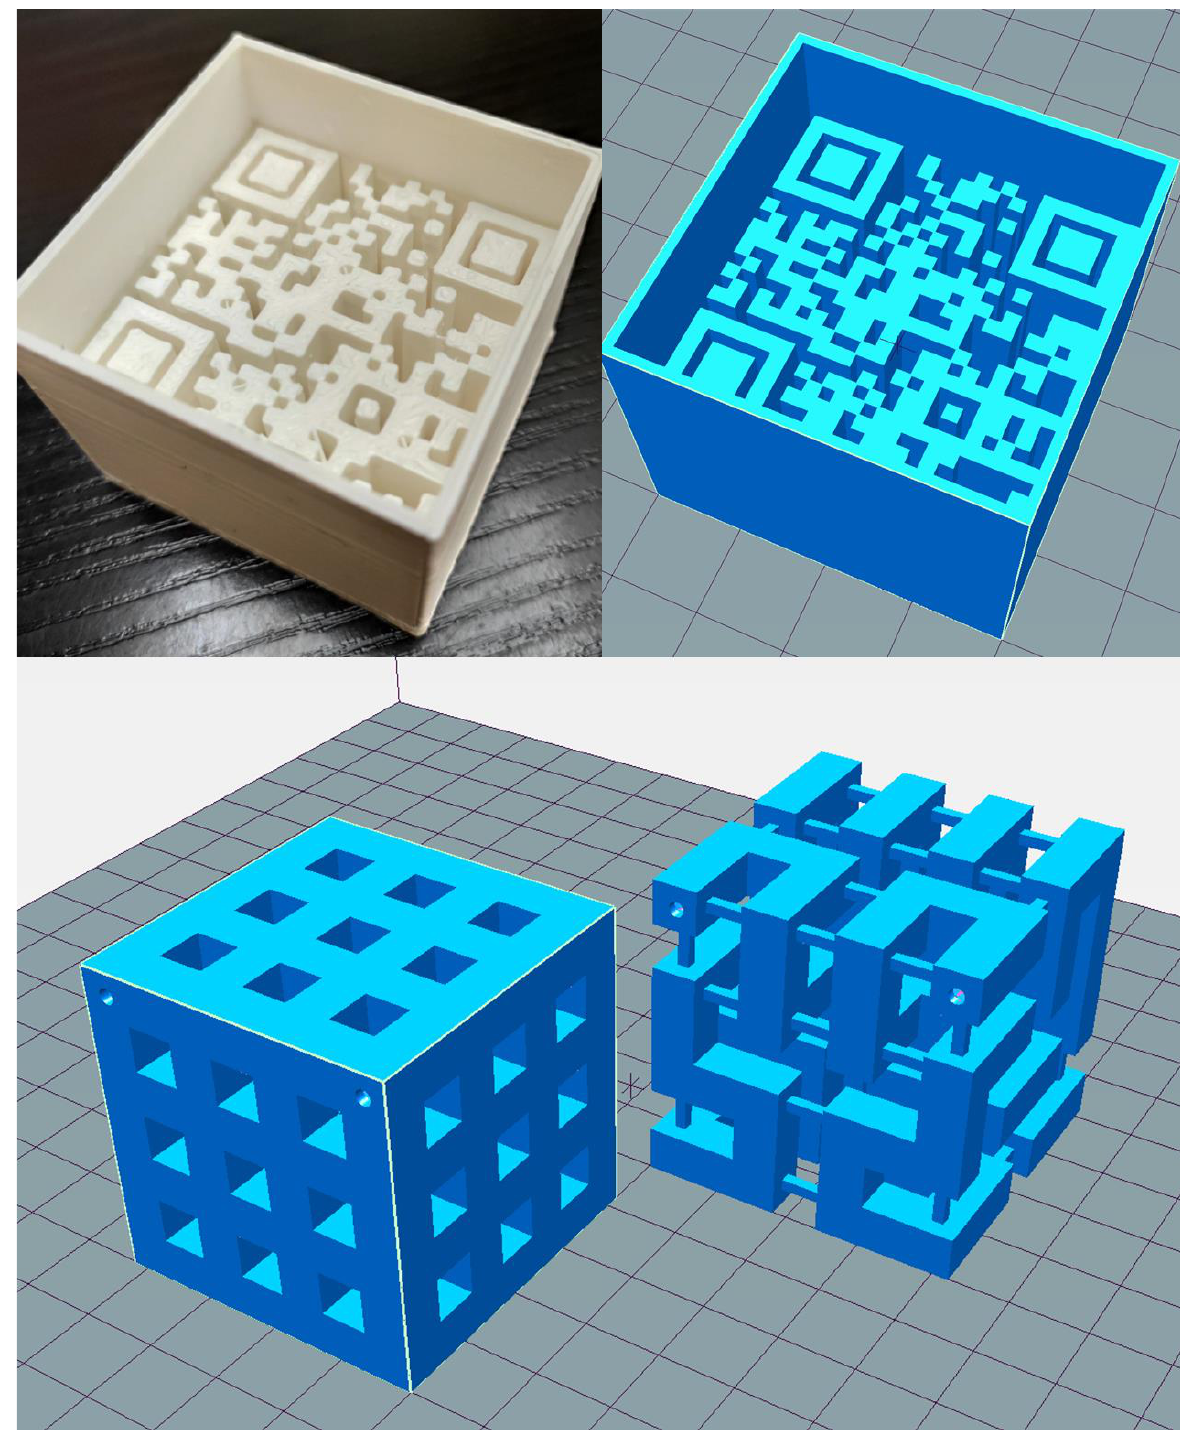
Figure 2. Representative photo and model images of the 3D printed phantoms: the top row shows a photo and the design image of the QR code, while the bottom row shows the design images of the modified Hilbert cube after and before modeling from left to right.